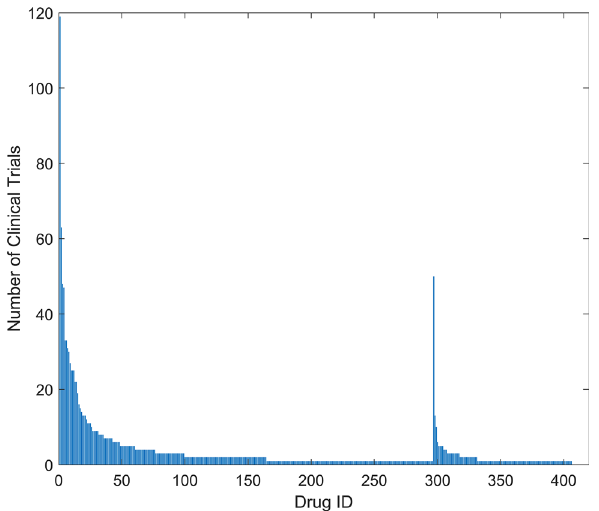
Figure 1. Clinical trials in ClinicalTrials.gov for COVID-19 drugs. The x-axis indicates drug ID that is given in Supplementary Table 1. The y-axis shows the number of clinical trials (data were obtained on June 3, 2021)